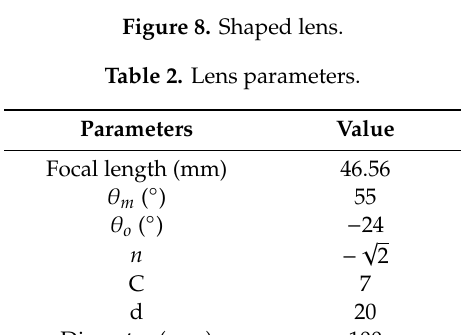
Figure 8. Shaped lens . Table 2. Lens parameters.